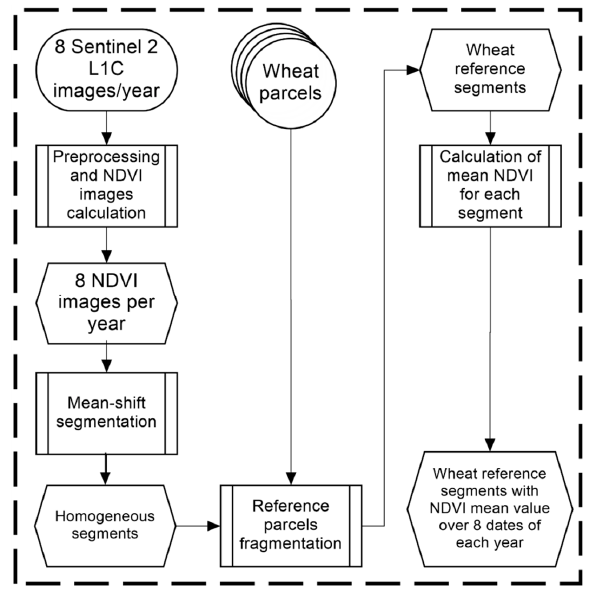
Figure 3. Simplified flowchart for the preparation of SEWMA NDVI temporal profiles.